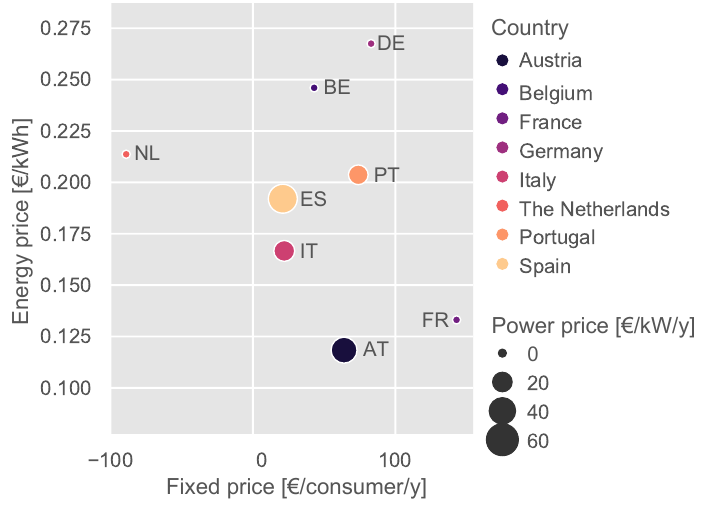
Figure 4. Electricity retail prices for eight European countries used in the simulation split in energy-, power- and fixed